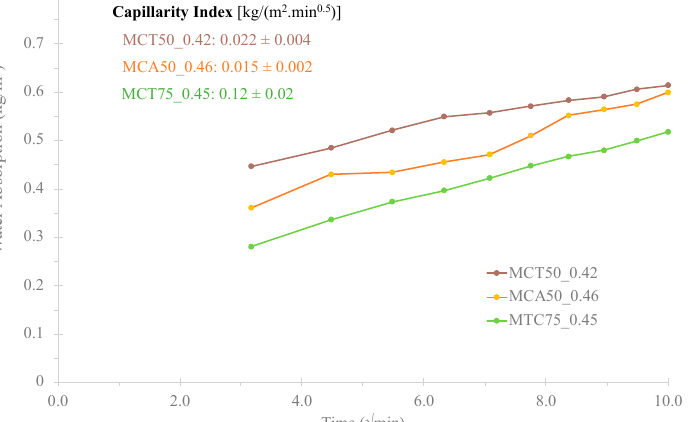
Figure 8. Water absorption by capillarity of MCT0.42FA50, MCA0.46FA50 and MCT0.45FA75 specimens.